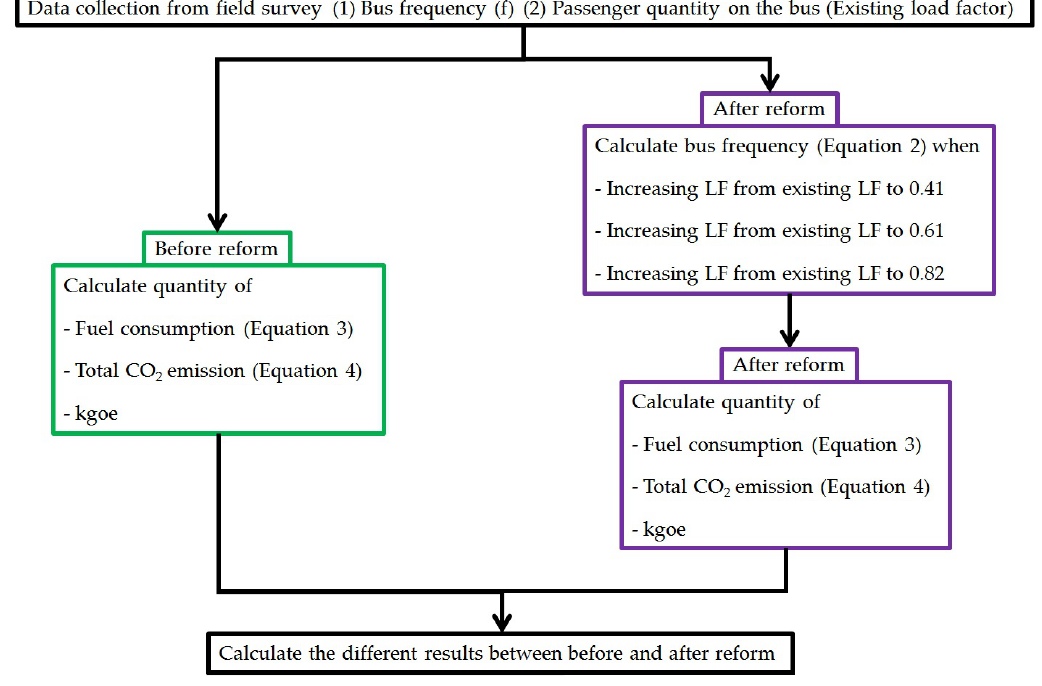
Figure 3. Calculation Framework of energy saving by using the Partial Bus Routes Reduction in Urban Fringe Model (PBRU) and CO 2 emission reduction along the Rama 2 Road after bus route reform.